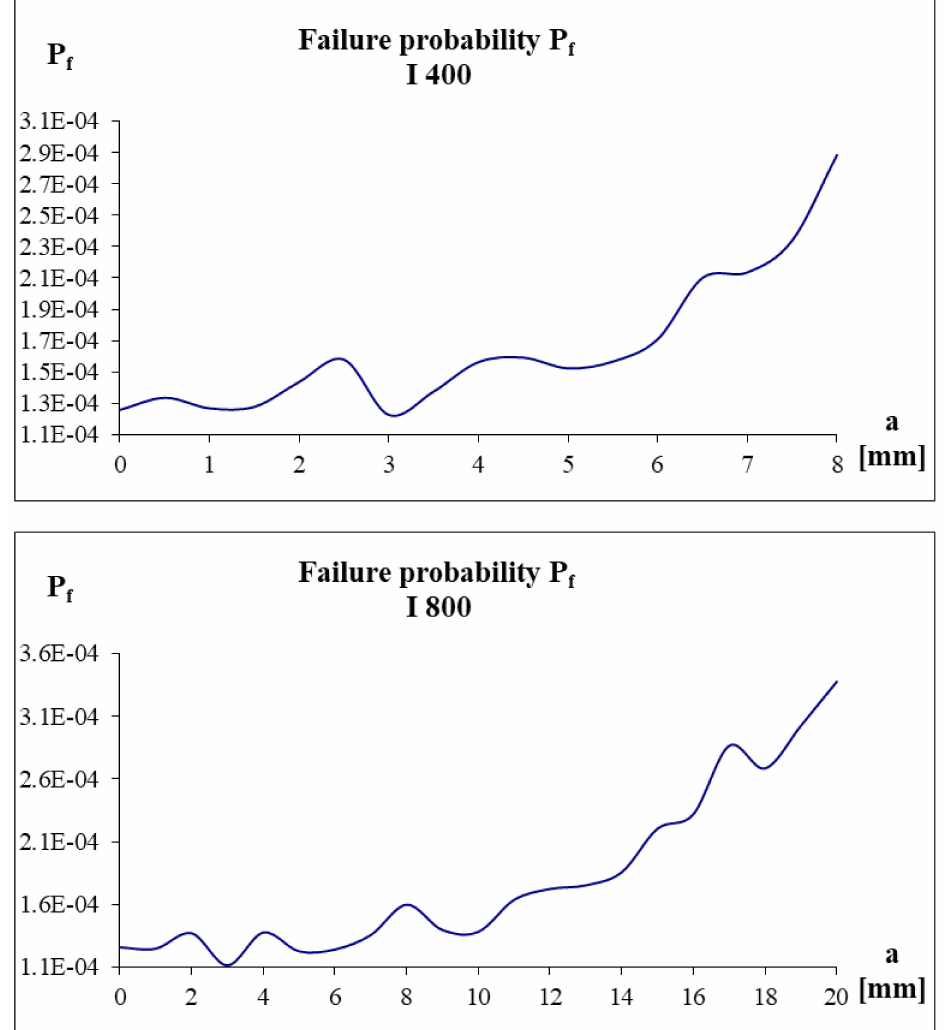
Figure 14. Dependence of failure probability P f on crack depth